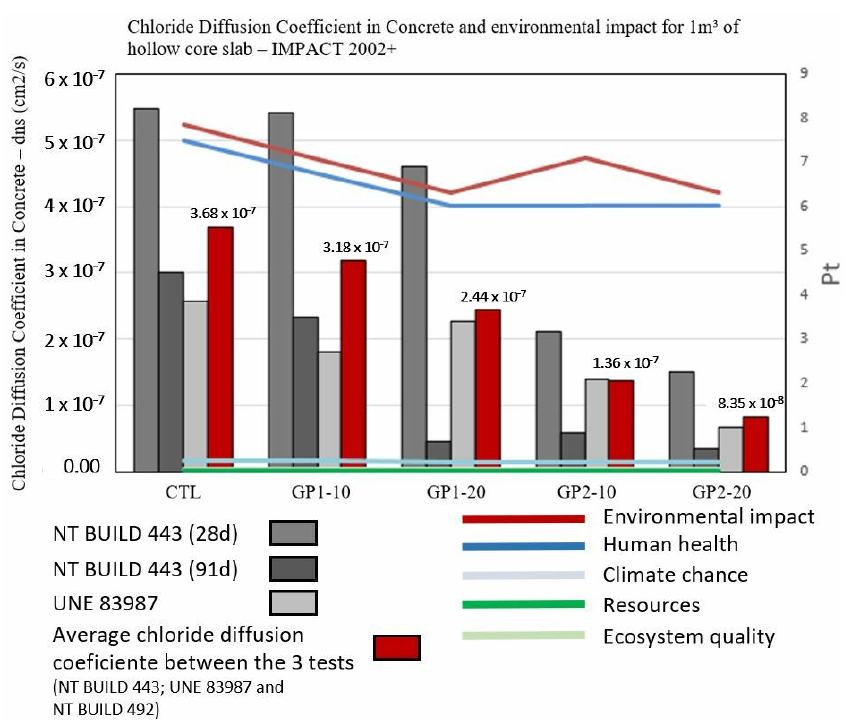
Figure 16. Chloride diffusion coefficient versus environmental impact.